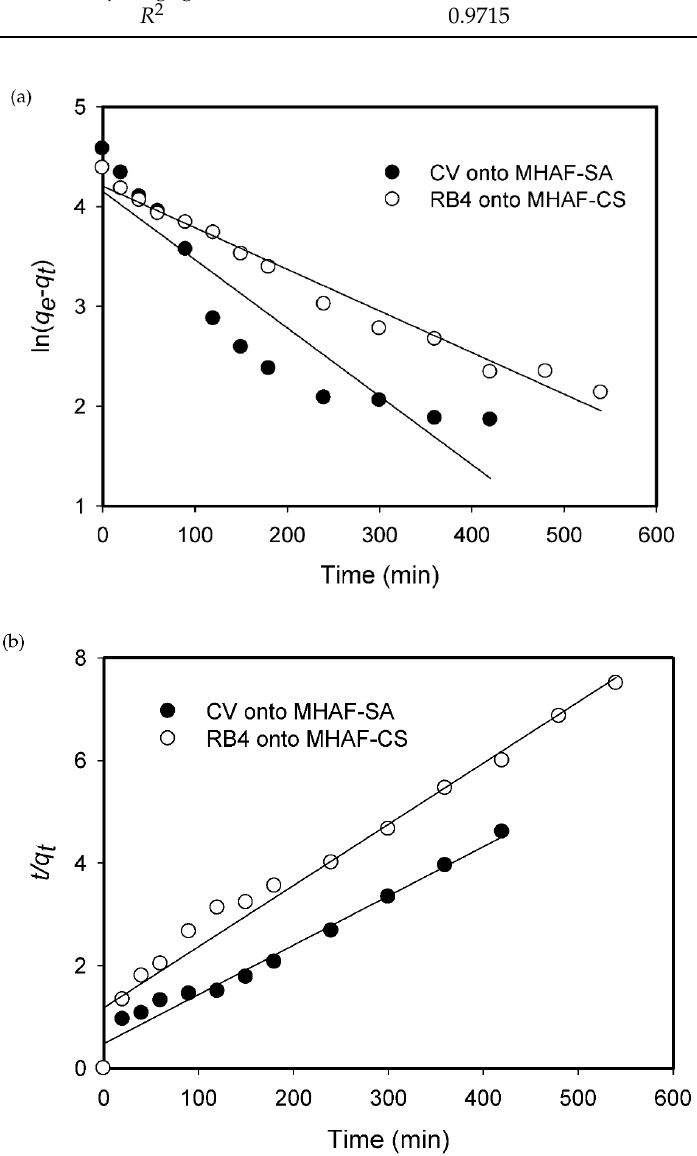
Figure 8. Kinetics models for dyes adsorption: ( a ) pseudo-first-order model, ( b ) pseudo-second- order model.